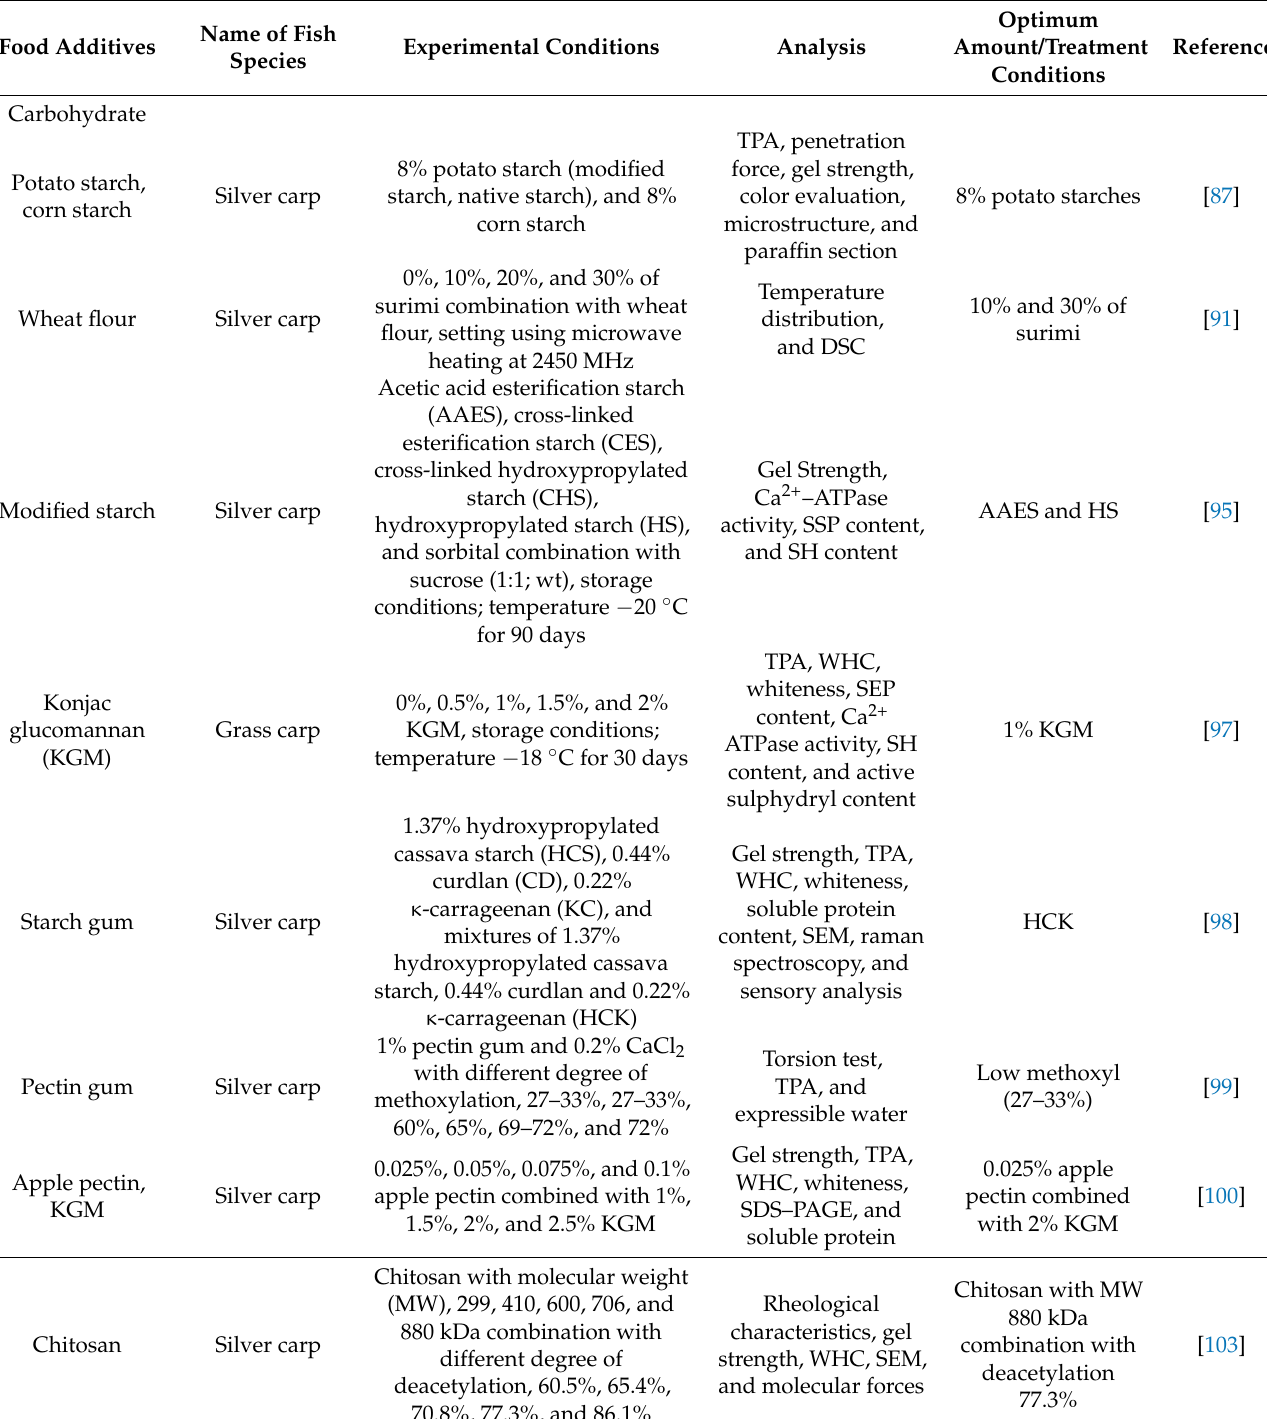
Table 2. The functional ingredients and their optimum conditions to enhance the quality of surimi and surimi